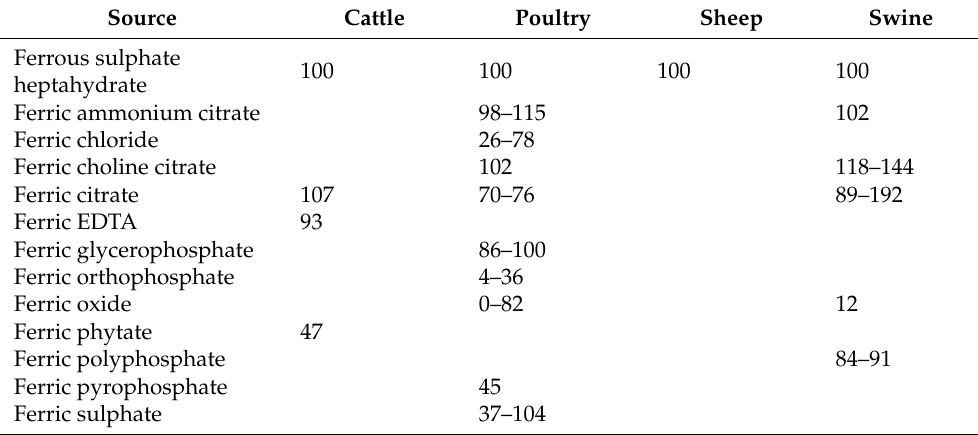
Table 5. Multi-species table of relative bioavailability values (%) for iron 1,3